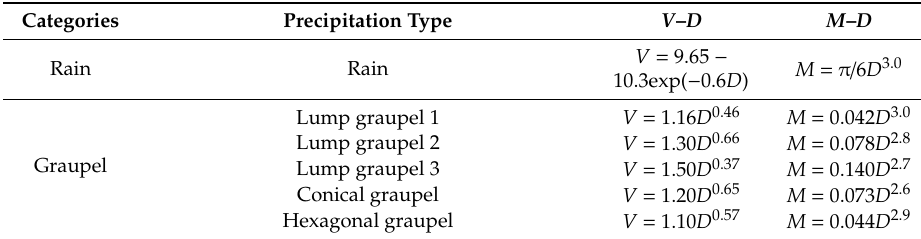
Table A1. Empirical relationships of velocity (m / s)–diameter (mm) ( V – D ) and mass (mg)–diameter (mm) ( M – D ) for di ff erent types of precipitation. The empirical relationships of graupel and snow are derived from Locatelli and Hobbs [29]. The empirical relationships of rain are derived from Atlas et al.